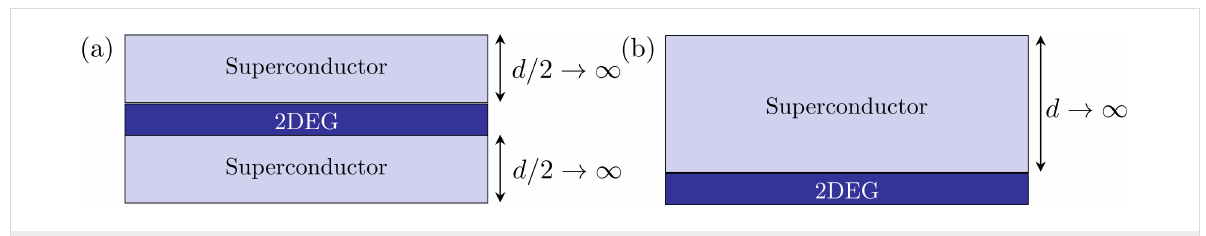
Figure 4: (a) Evaluating the self-energy with the Green’s function of a bulk superconductor (see Equation 26) corresponds to a 2DEG embedded within an infinitely large superconductor. (b) Evaluating the self-energy with the Green’s function of a semi-infinite superconductor (see Equation 27) corresponds to a 2DEG placed on the surface of an infinitely large